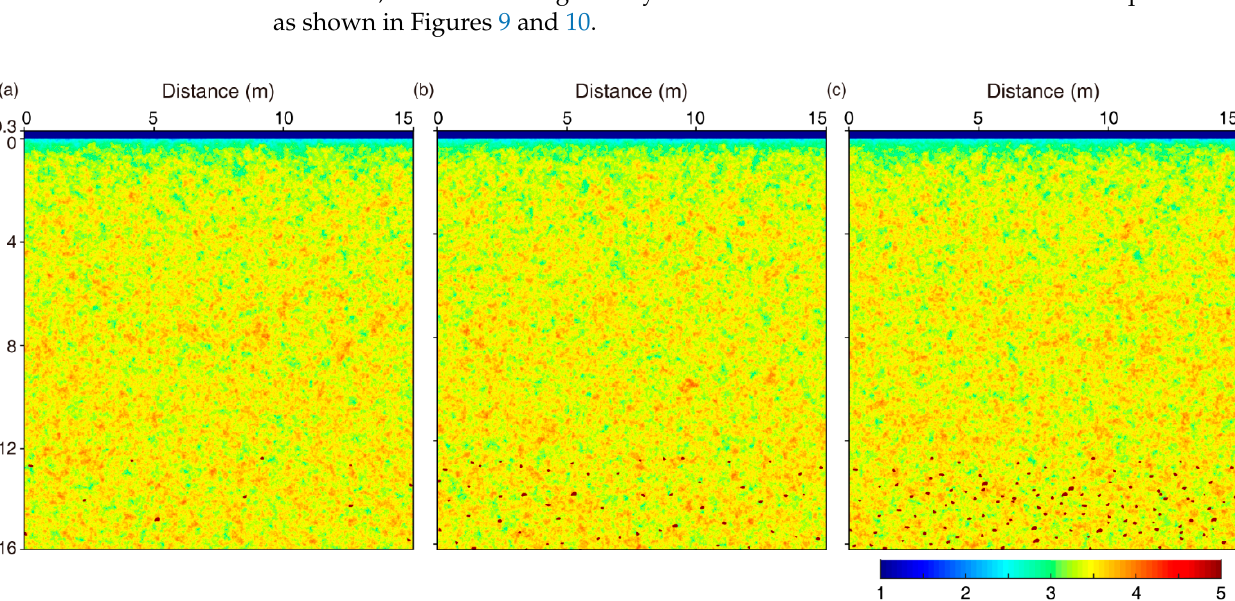
Figure 9. The ejecta model with small ( a ), medium ( b ), and large ( c ) spatial densities of rocks.